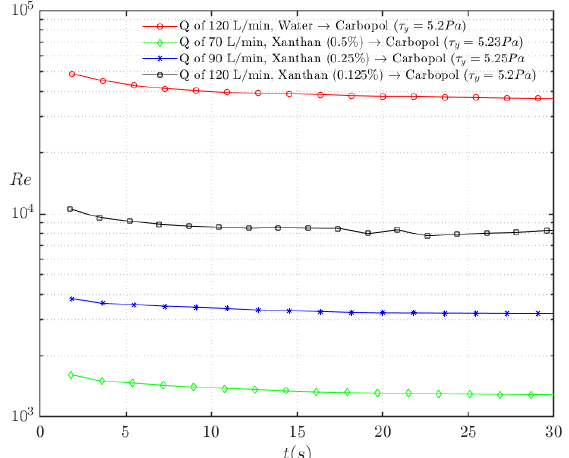
Figure 14. Computed Reynolds number for the displacing fluid in an imposed pressure drop